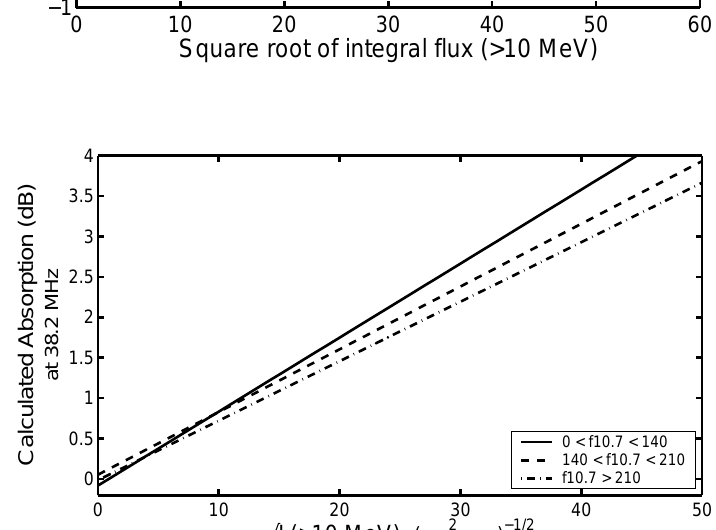
Fig. 9. Flux-absorption relationship calculated for four separate PCA/SPE. Coefficients of the fit are displayed in Table 4. Both April 2001 and Septem- ber 2001 had similar geomagnetic ac-